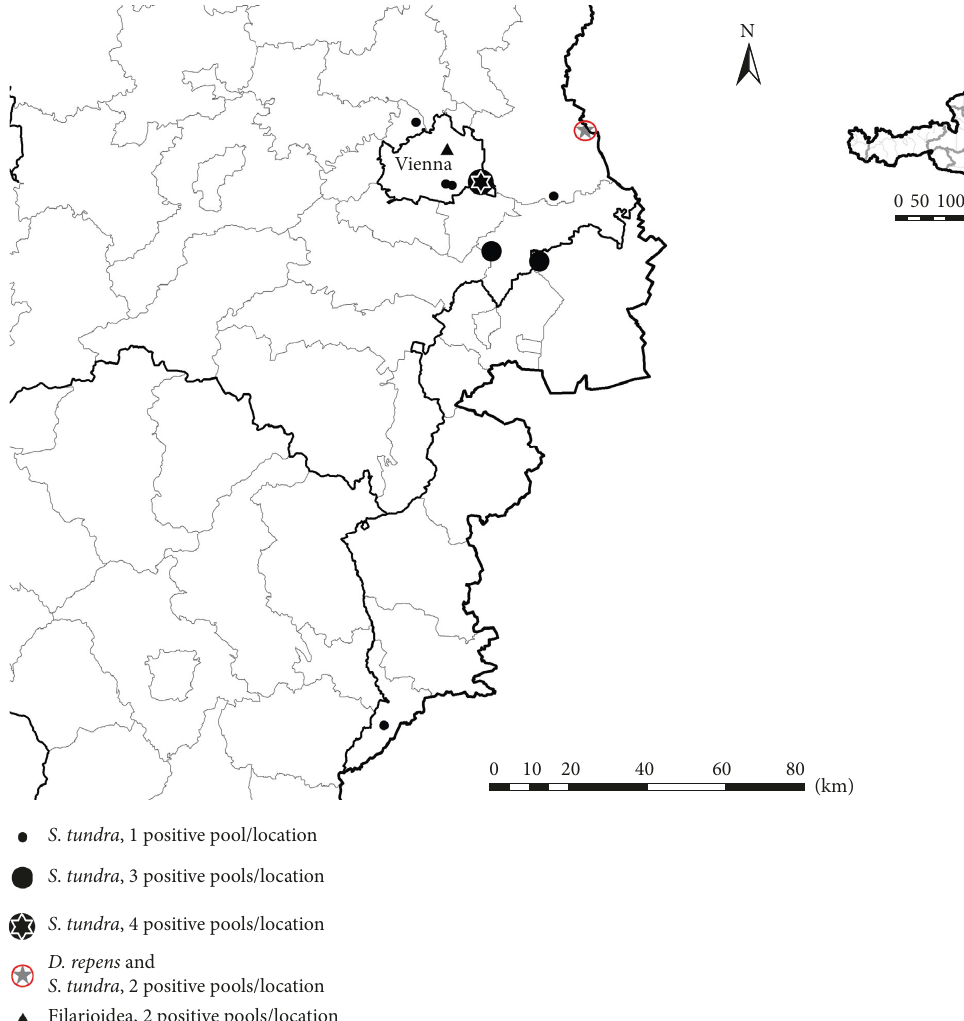
Figure 1: Geographic distribution of mosquito pools positive for filarioid helminths in Eastern